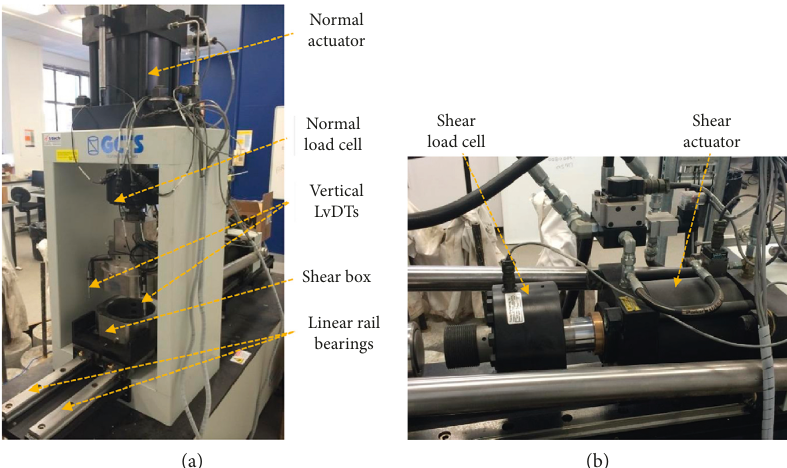
Figure 6: Frame of the GCTS direct shear test system RDS-300. (a) Front view; (b) shear actuator component (after Li et al.